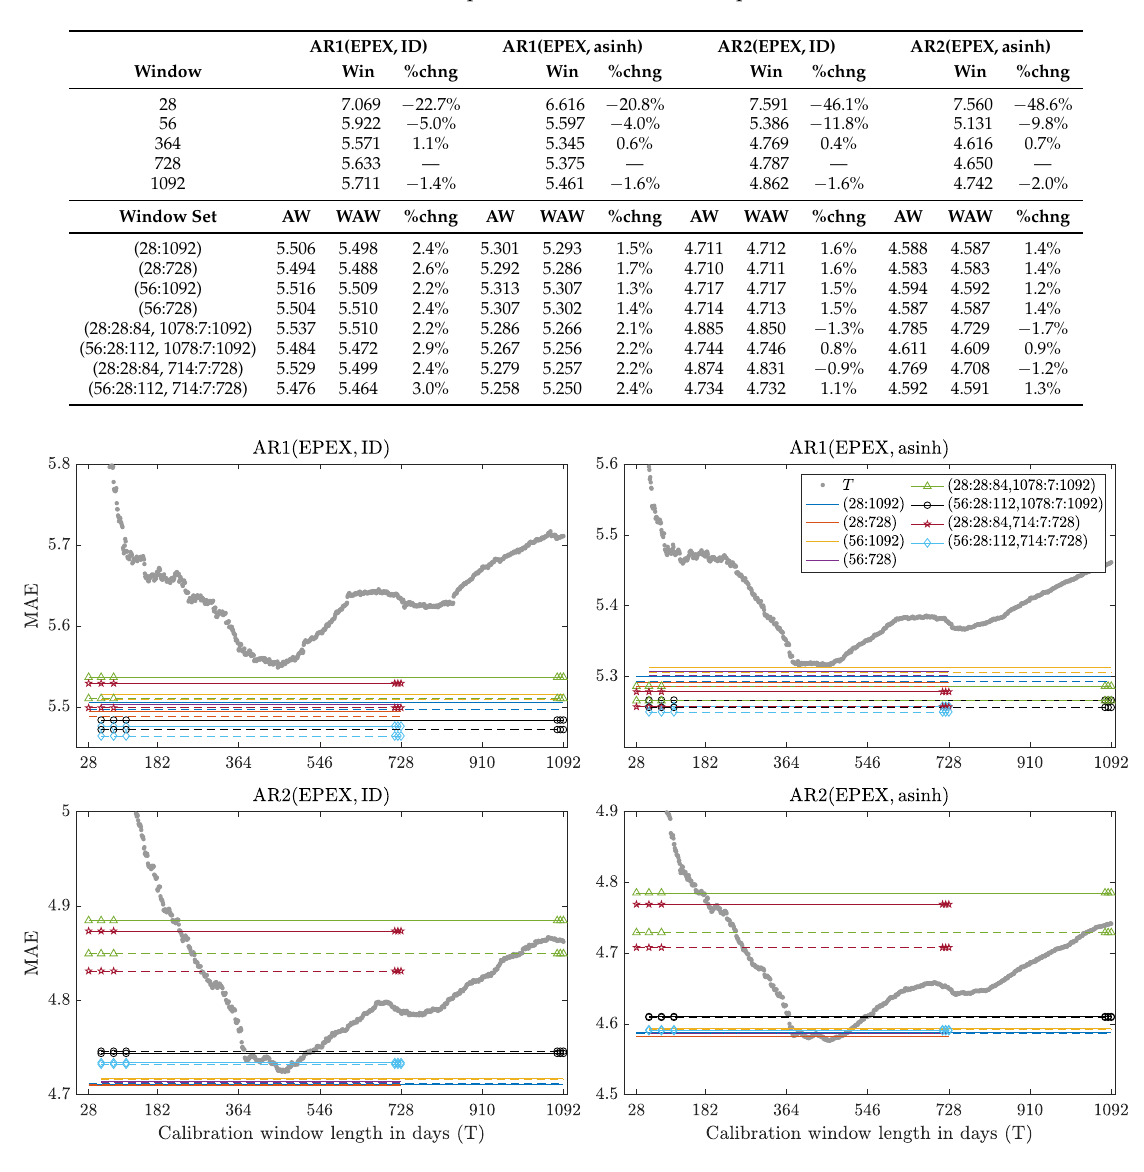
Figure 7. Mean absolute errors (MAE) for the EPEX dataset as a function of the window length T = 28,...,1092 (gray circles) and obtained by combining forecasts (the color/line/symbol scheme and the location of panels is the same as in Figure 6). Note the different scales. Out-of-range lines or symbols are not